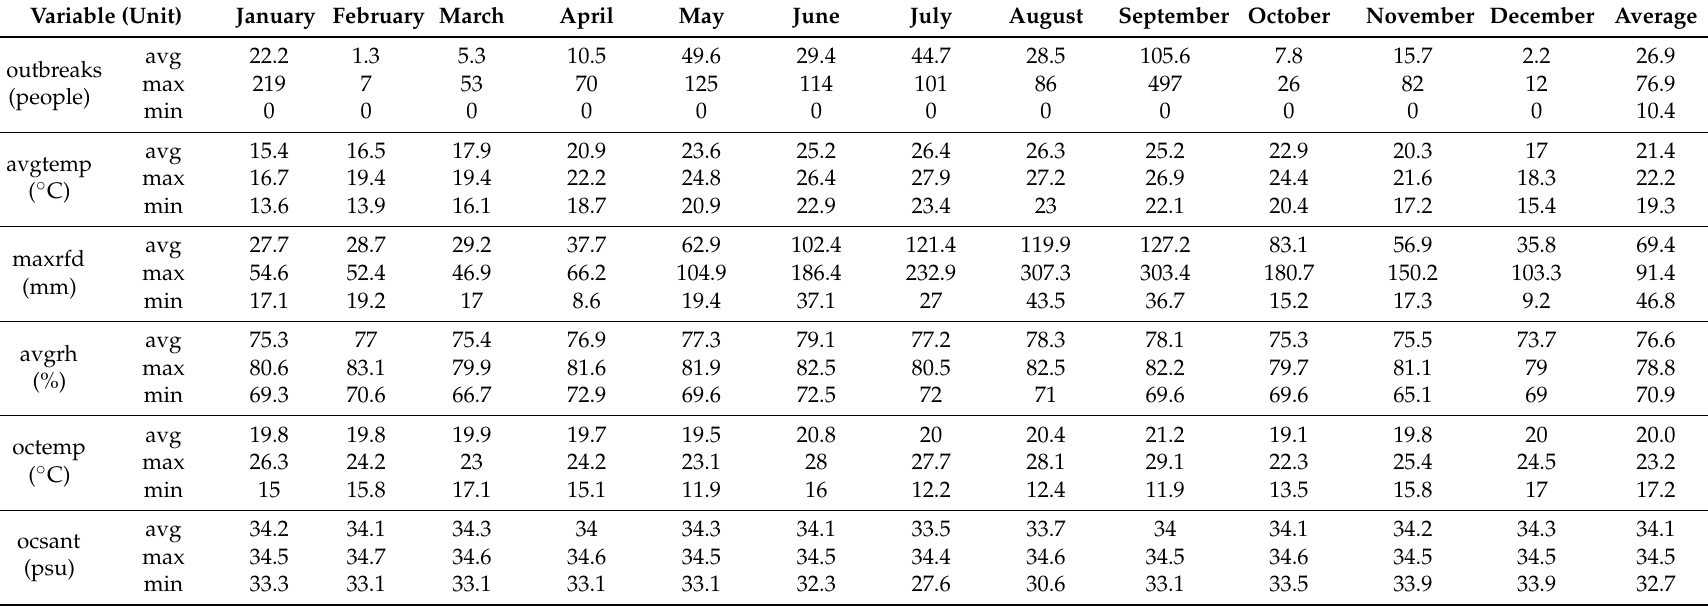
Table 3. The average, maximum and minimum values of outbreak variable and climatic variables by month from 2000–2011.